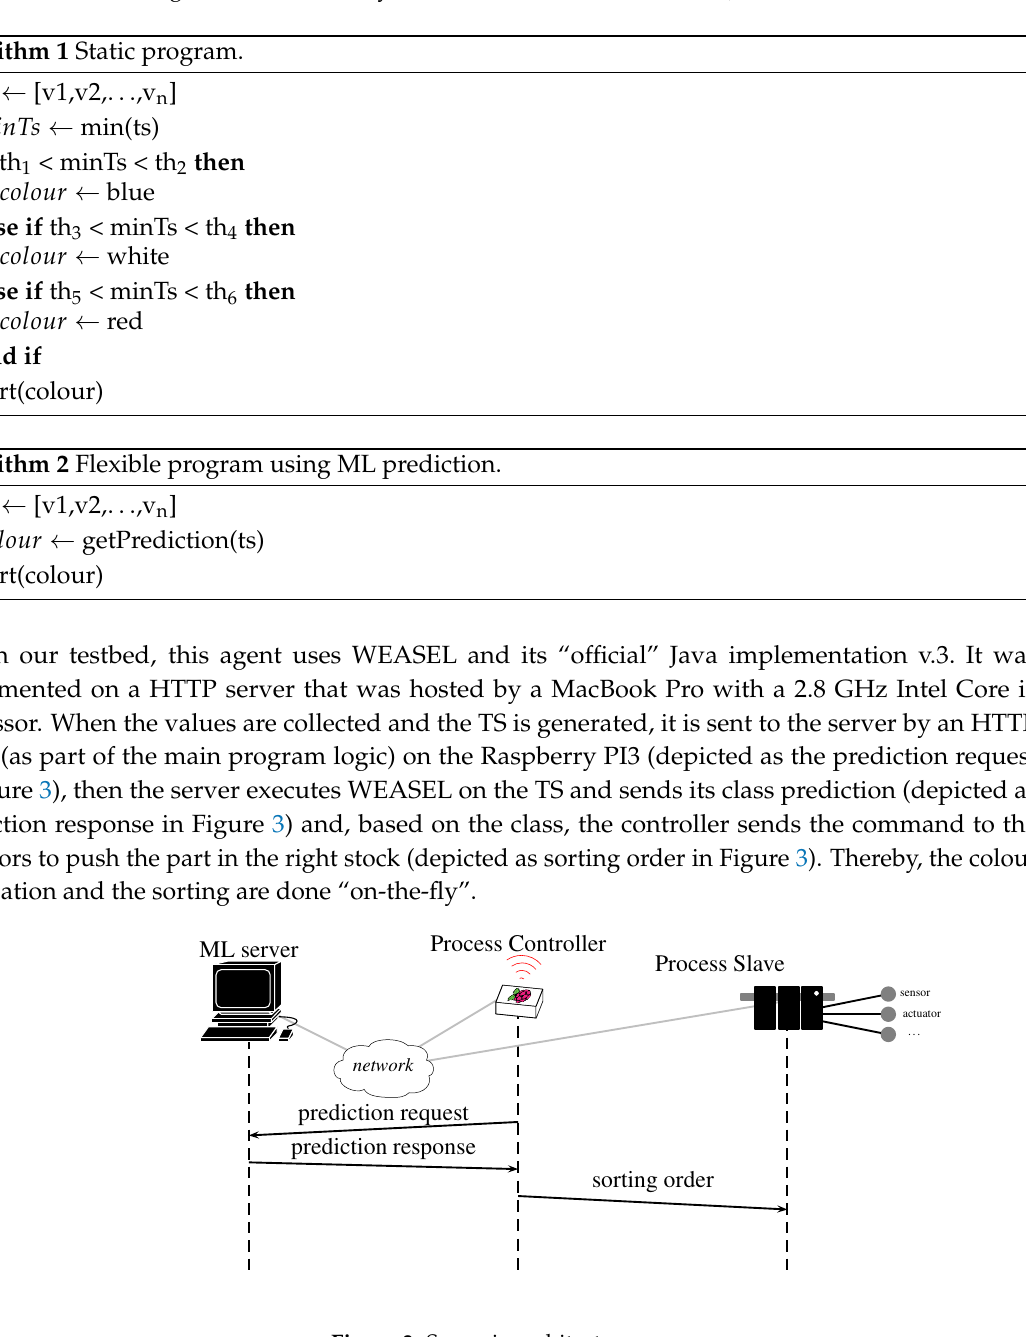
Figure 3. Scenario